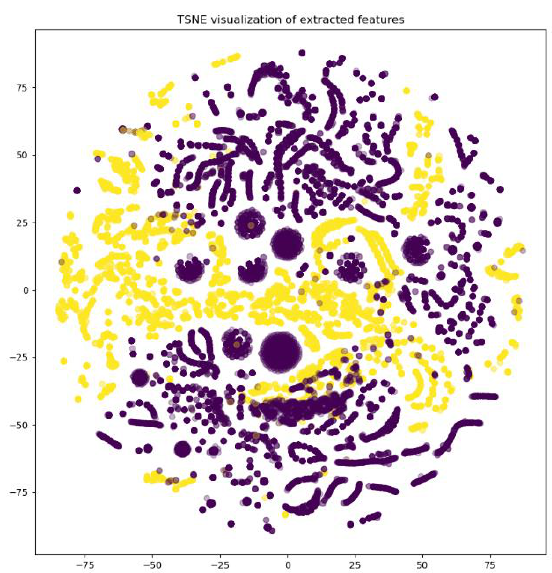
Figure 15. T-SNE dimensionality reduction classification result. The available features selected by the bivariate analysis were used to plot the reduced dimensional t-SNE plot. As can be seen, the vast majority of samples are well separated, indicating that these features are useful.